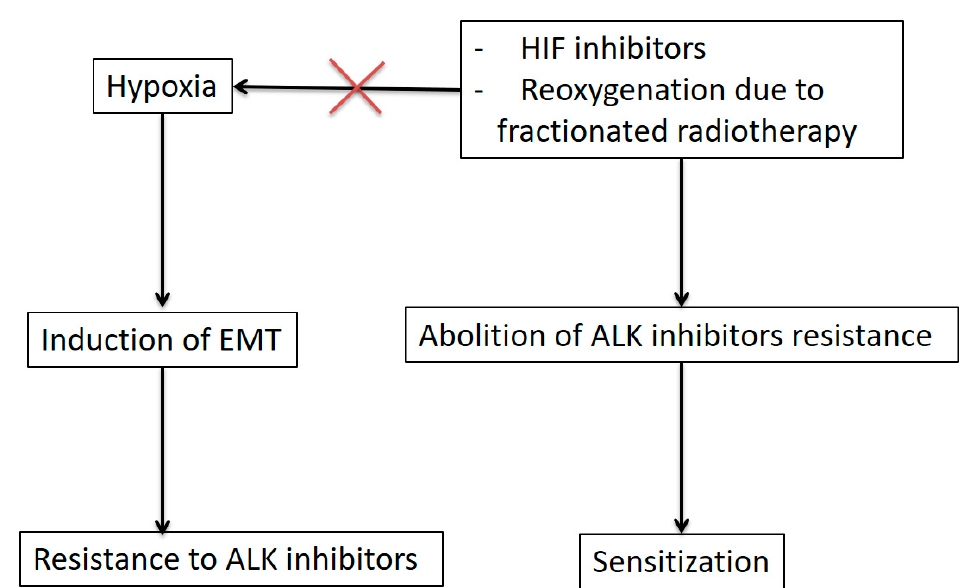
Figure 2. Role of hypoxia in ALK inhibitor resistance and the ability of radiation therapy to overcome this resistance. ALK: anaplastic lymphoma kinase, EMT: epithelial–mesenchymal transition, HIF: hypoxia inducible factor.